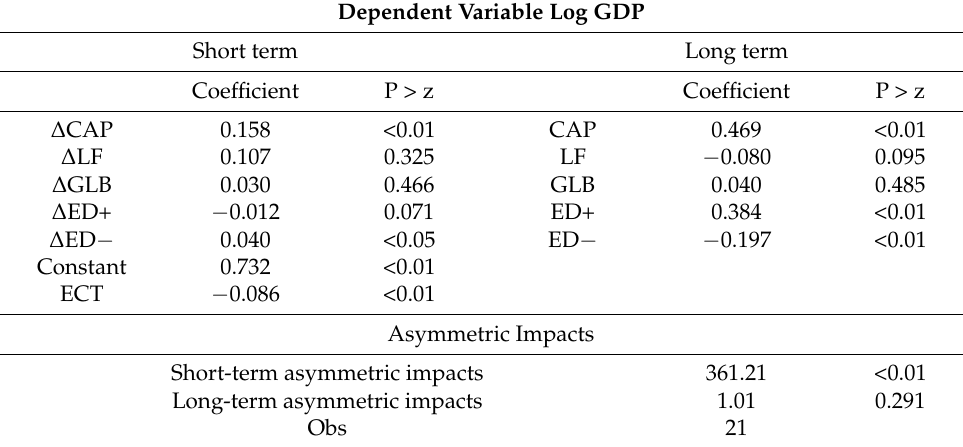
Table 4. Results of the NPARDL